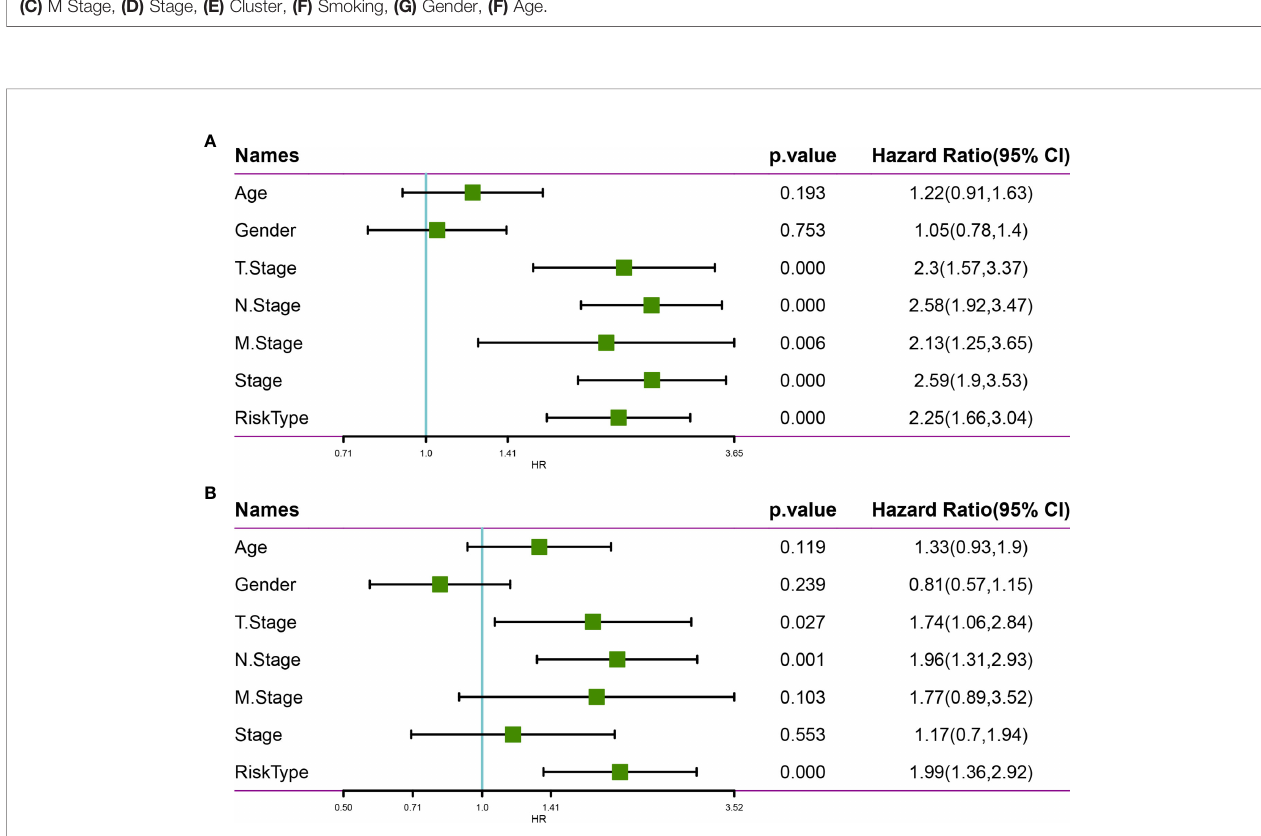
FIGURE 11 | Comparison of RiskScore distribution based on clinical features and molecular subtype using the TCGA-LUAD dataset. (A) T stage, (B) N Stage, (C) M Stage, (D) Stage, (E) Cluster, (F) Smoking, (G) Gender, (F) Age.